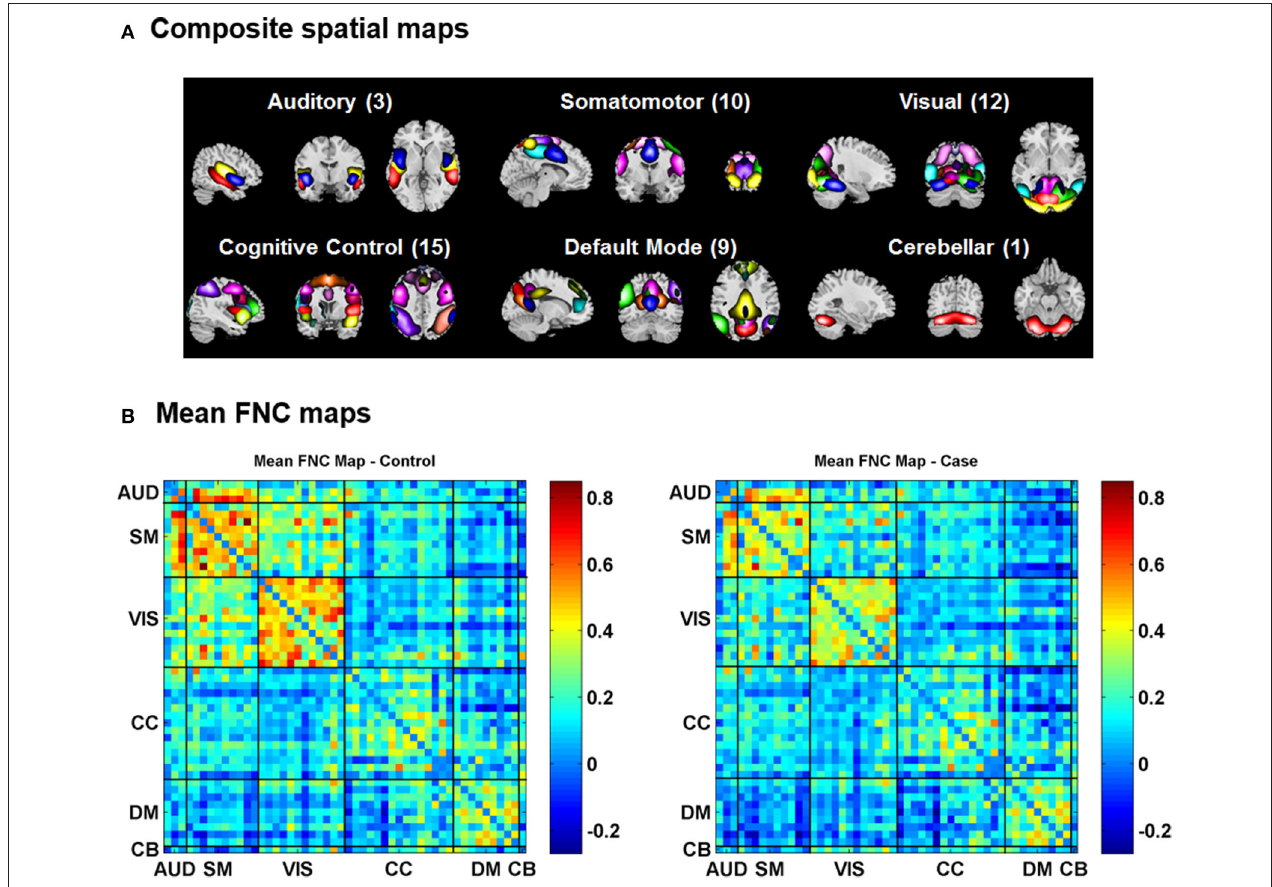
FIGURE 4 | (A) Composite spatial maps of the resting-state networks. (B) Mean FNC maps of the control (left) and patient (right) groups.